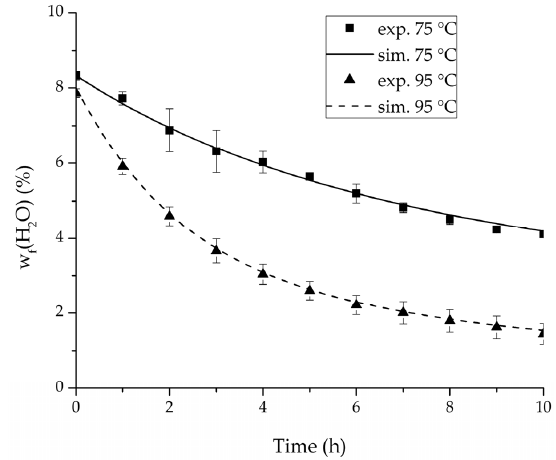
Figure 16. Experimental and simulation permeate fluxes for the ternary system at 95 °C feed temperature.